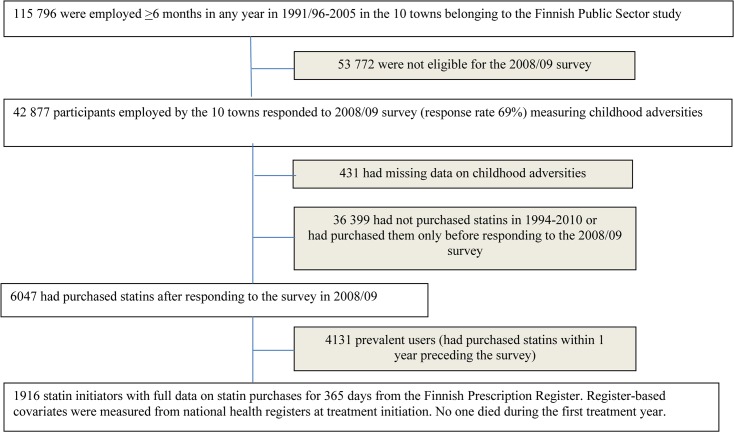
Chart of the sample selection.